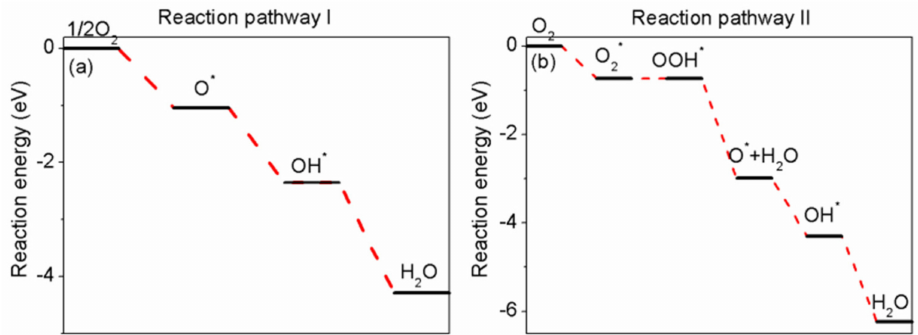
Figure 5. The reaction energy diagram on Pd/Pd–Cu(110) surface of ( a ) reaction pathway I and ( b ) reaction pathway II.